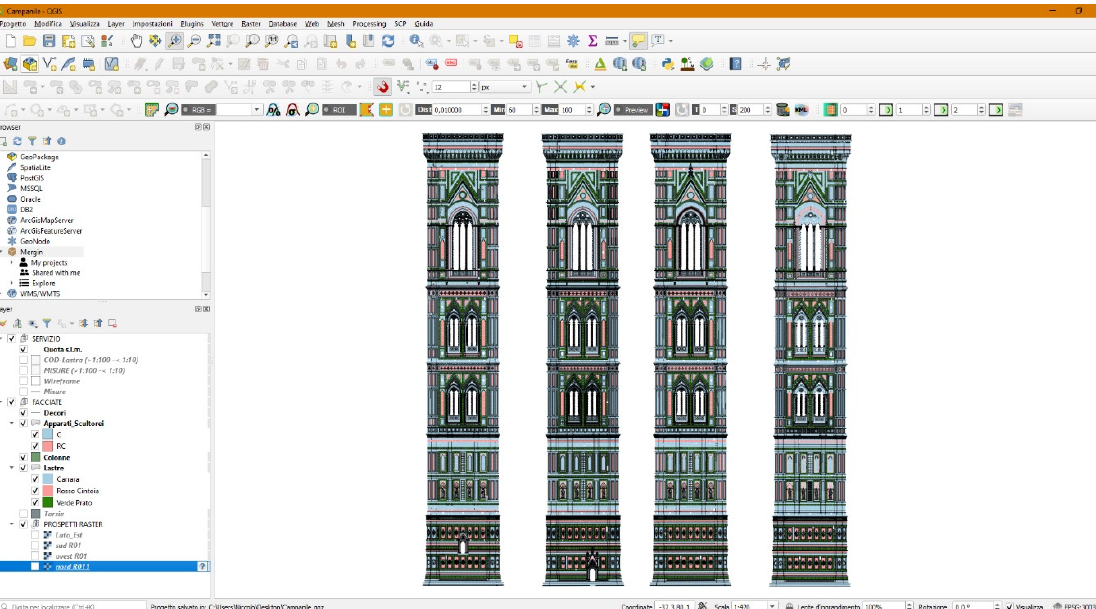
Figure 3. QGIS's project of Giotto’s Campanile.